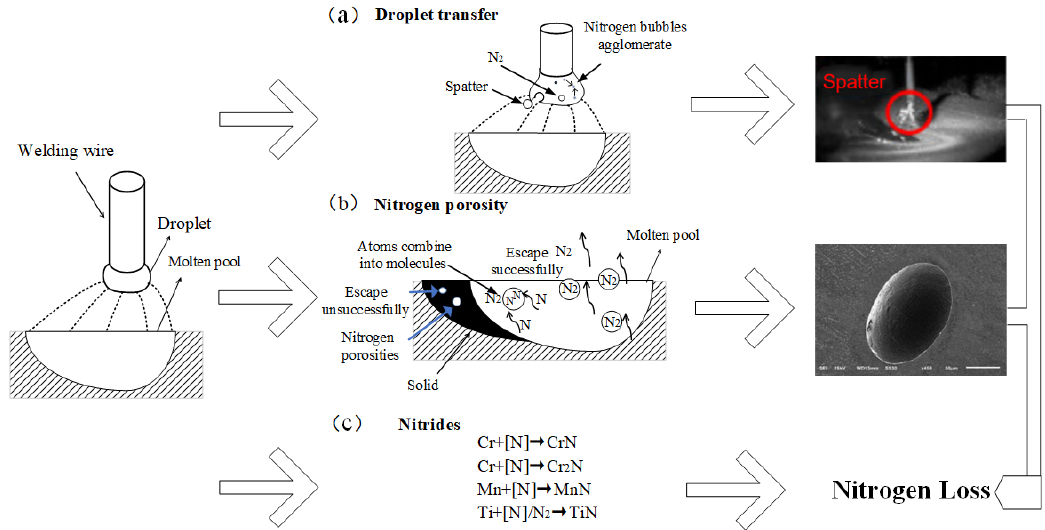
Figure 1. Problems in the welding of HNS. ( a ) Instability of droplet transfer. Reprinted with permission from ref. [7]. Copyright 2022, Elsevier. ( b ) N 2 Porosity, Reprinted with permission from ref. [13]. Copyright 2021, Elsevier. ( c ) Nitrogen Loss.